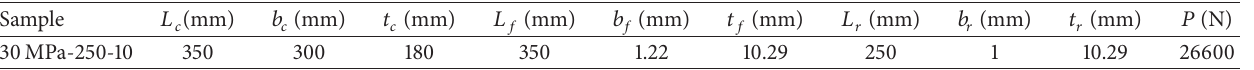
Table 3: The detailed dimensions of each three parts.